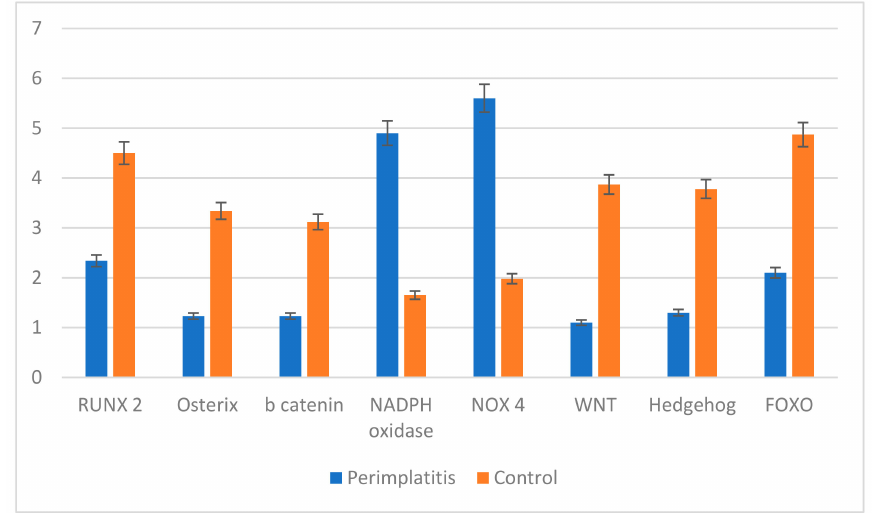
Figure 12. Gene expression of genes related to osteogenesis (RUNX, Osterix, b Catenin); RO production (MADPH oxidase; NOX4); pathway related to osteogenesis (WNT, HEDGEHOG,